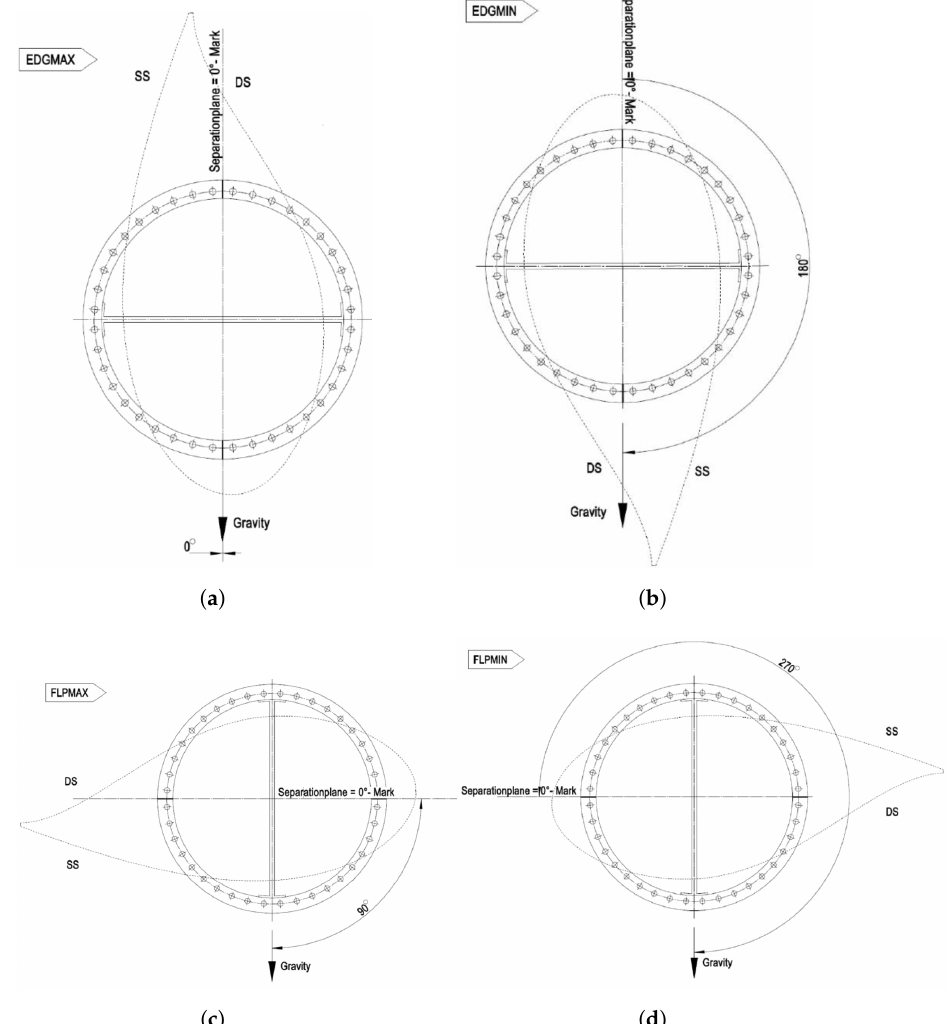
Figure 4. Rotor blade orientation for all bending and torsion load cases. ( a ) Blade orientation during load case Mxmax. ( b ) Blade orientation during load case Mxmin. ( c ) Blade orientation during load case Mymax and torsion tests. ( d ) Blade orientation during load case Mymin.